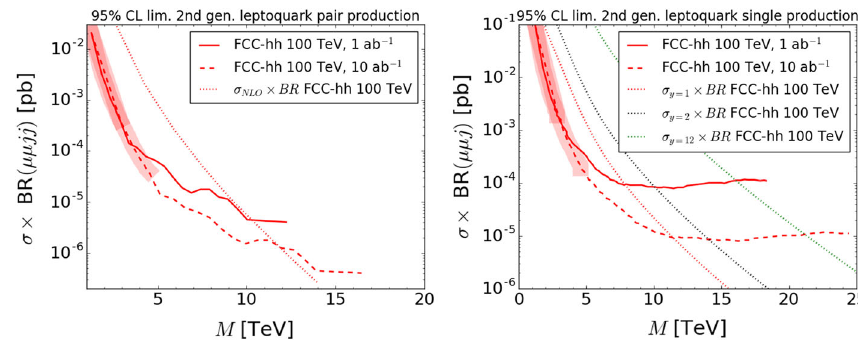
Fig. 14.2 Projected 95% CL exclusion limit at FCC-hh for leptoquark pair production on the left and single production on the right. The solid and dashed lines are for 1 and 10 ab − 1 . The dotted lines are the signal cross-section computed at NLO on the left, and, on the right, LO for couplings y = 1 , 2 , 12 in red, black, and green,